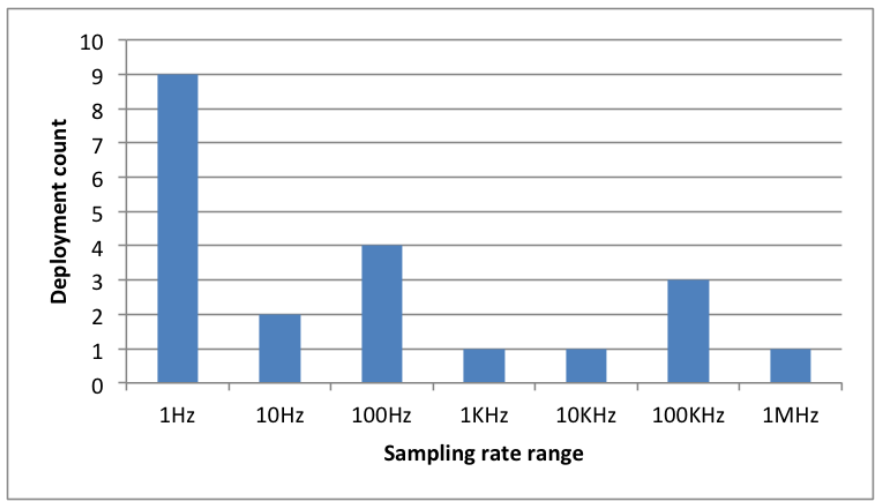
Figure 4. Sensor sampling rate used in deployments —Low duty cycle applications with sampling rate below 1 Hz are the most popular; however, high-frequency sampling is also used; the ranges 10–100 Hz and 10–100 kHz are popular.